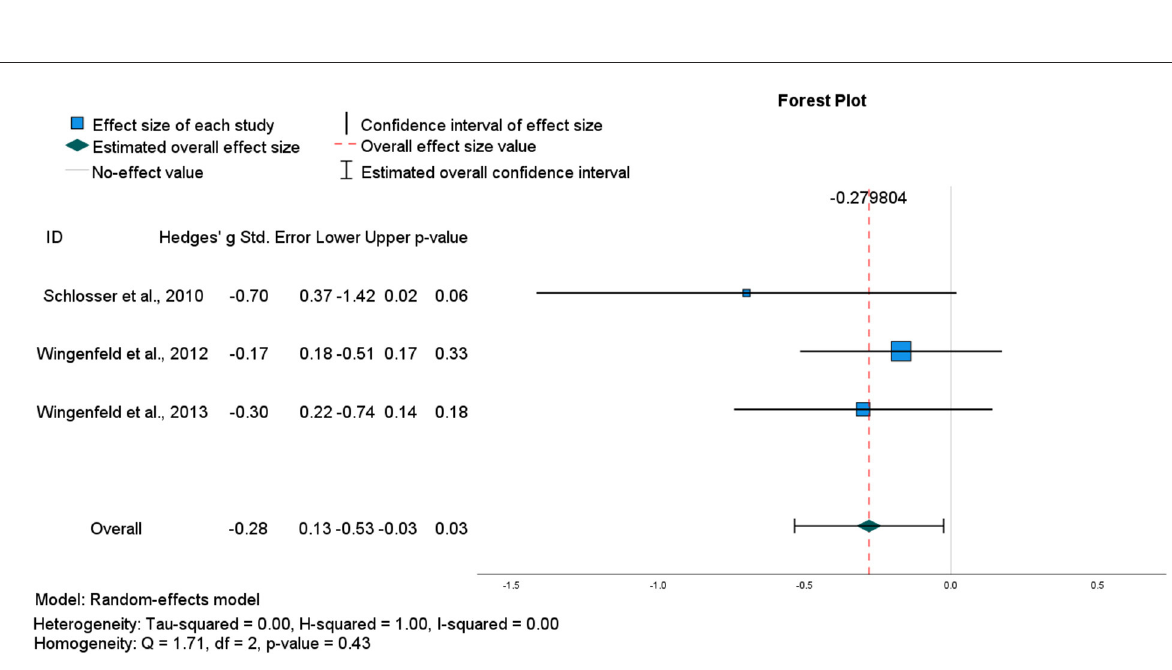
FIGURE3 Forest plot for final pooled studies of the (acute) effect of oral hydrocortisone (10mg) administration in healthy participants on the number of specific AMs